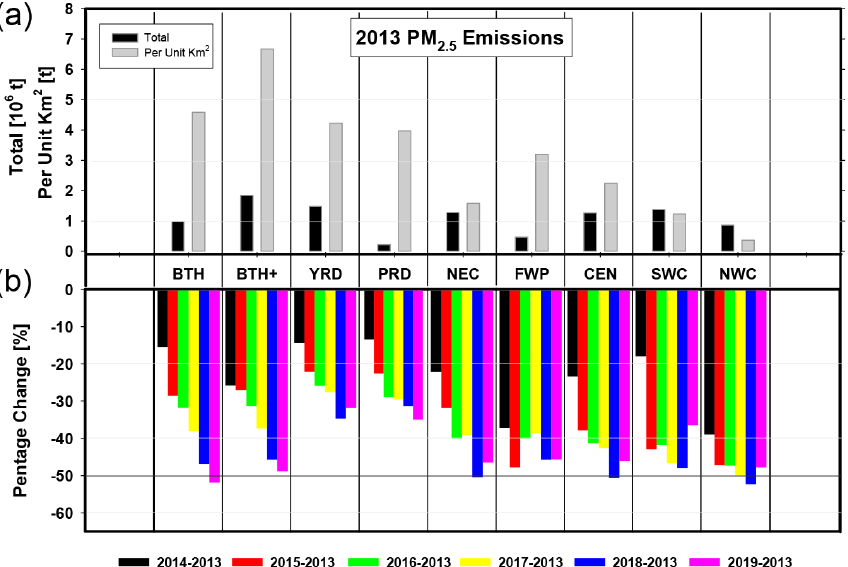
Figure 10. Annual PM 2 . 5 emissions (total and per unit km 2 ) for 2013 (a) and corresponding changing rates (b) from 2014 to 2019 as compared with 2013 in nine